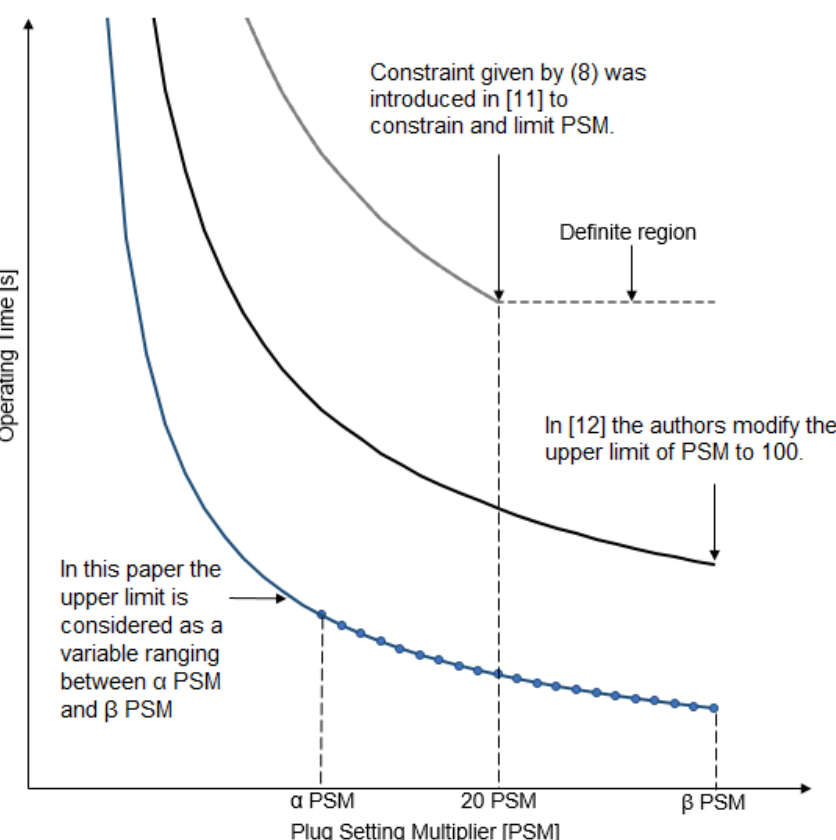
Figure 1. Proposed non-standard characteristic for overcurrent relay (OCR)